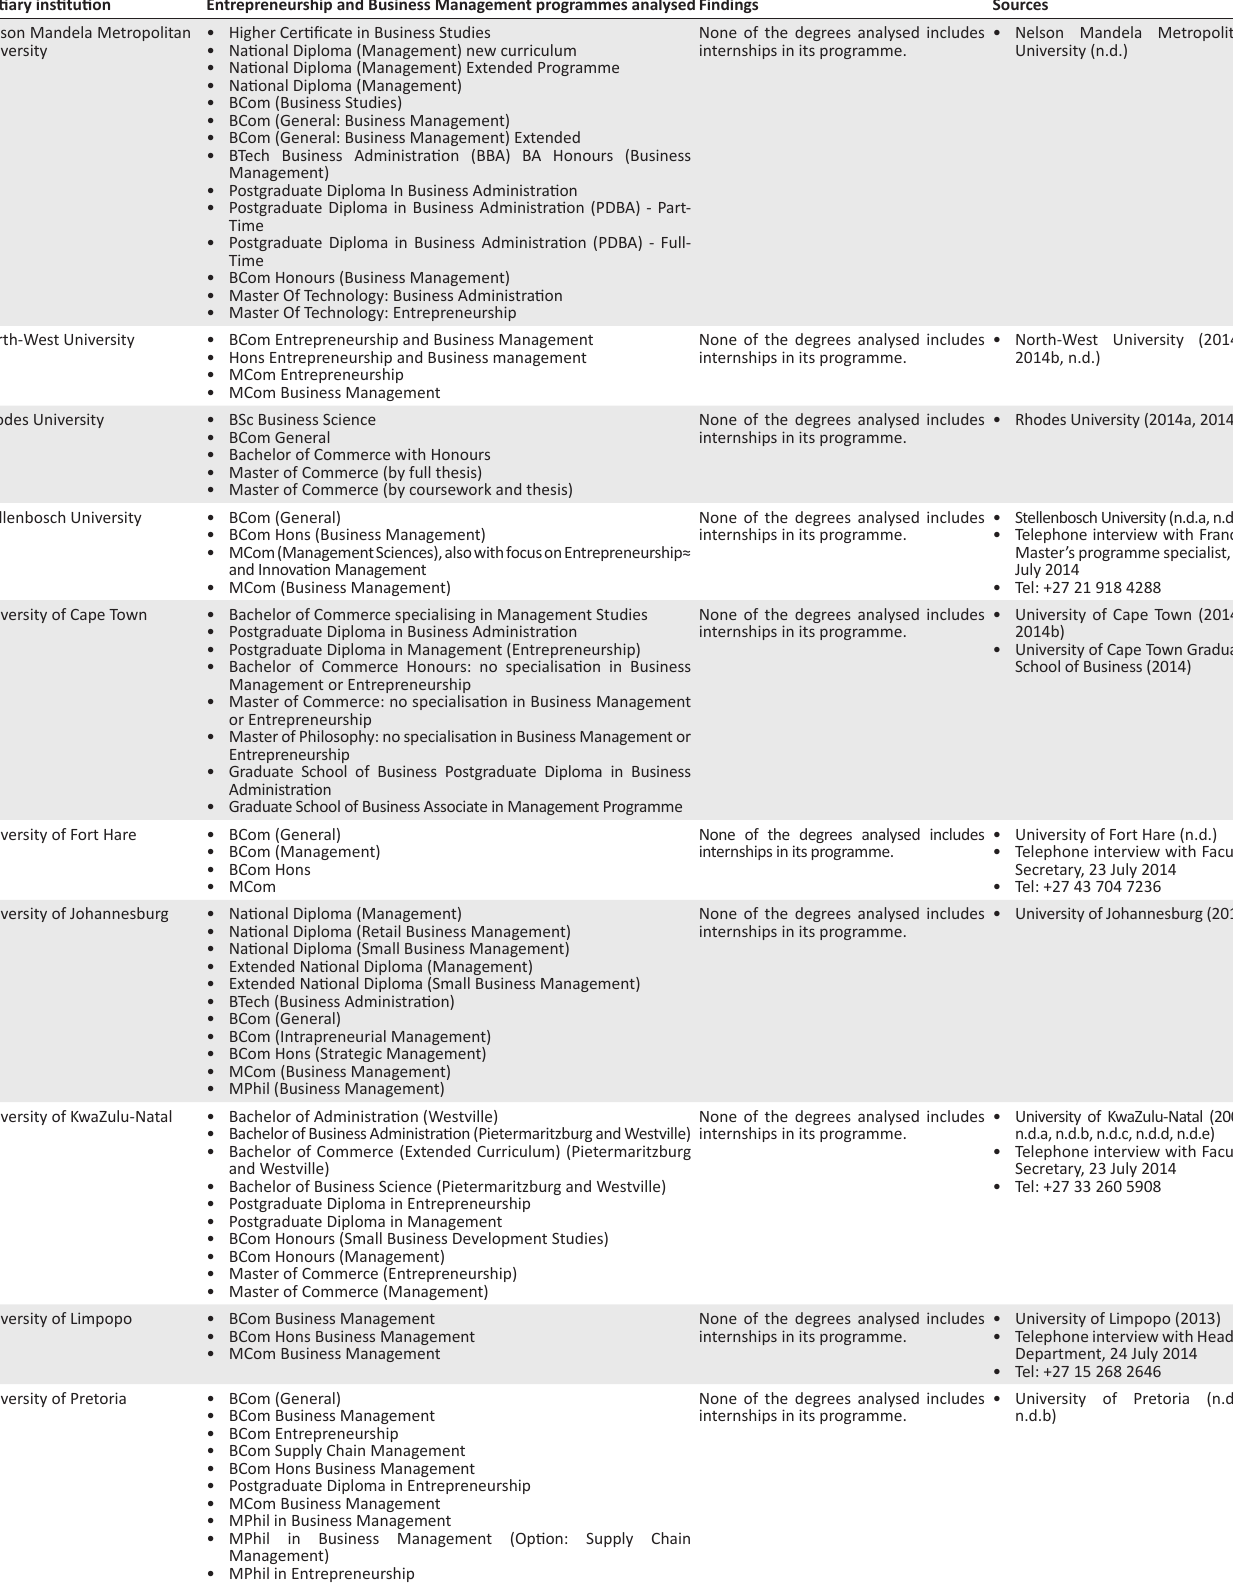
TABLE 1-A1: Survey results of South African tertiary institutions’ entrepreneurship and business management